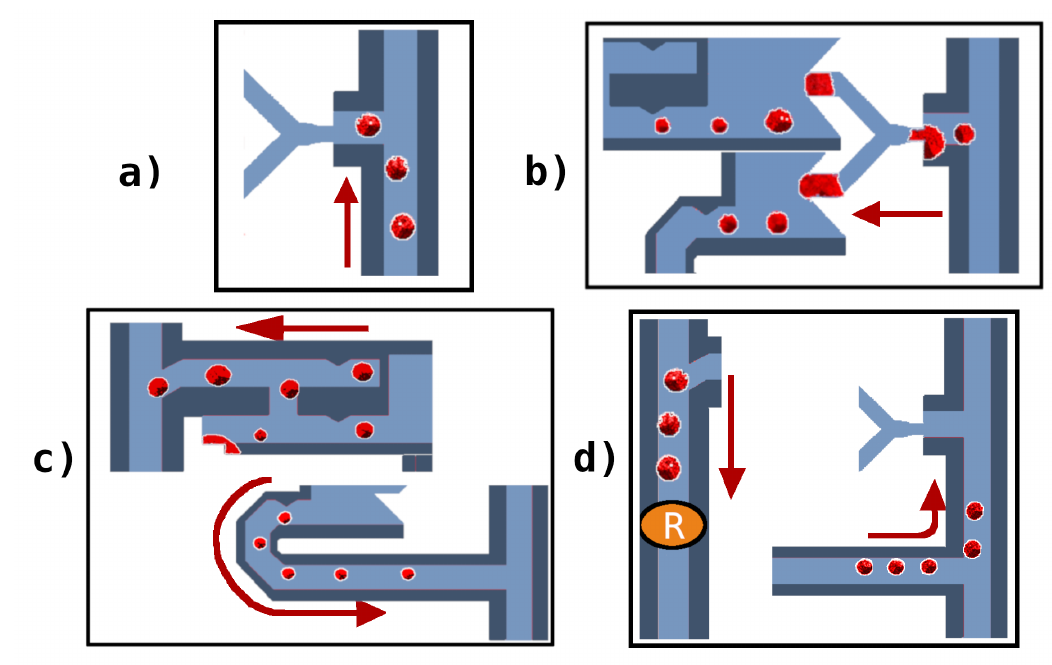
Figure 4. In figure the four phases of elaboration of the stored skyrmions. In ( a ) the information is moved from the memory track into the duplication gate. In ( b ) the information is duplicated by means of skyrmion-domain wall conversion. In ( c ) the information is processed on top and moved back to the memory cell on bottom. In ( d ) the result of the operation is read on the left, the information is restored into the cell on the